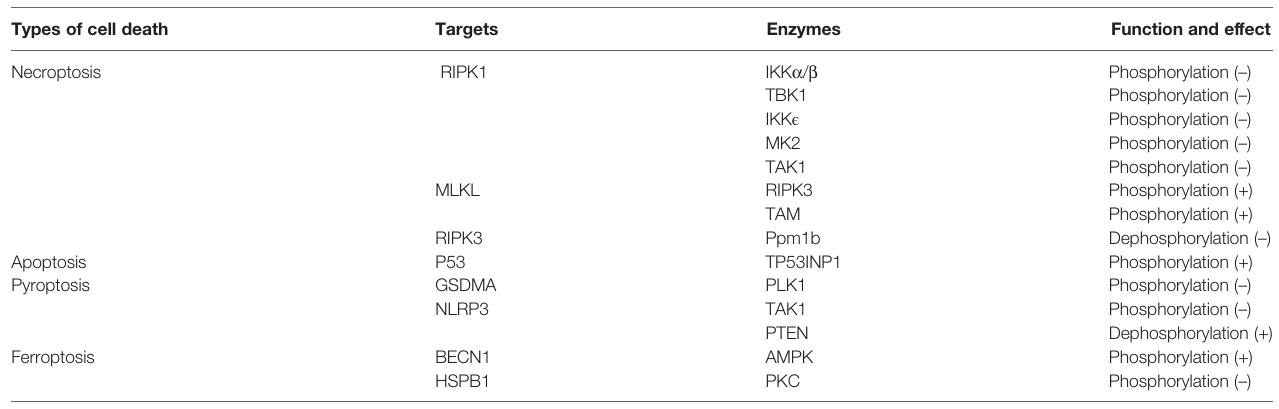
TABLE 3 | Key kinases and phosphatases that regulate in fl ammatory cell death.